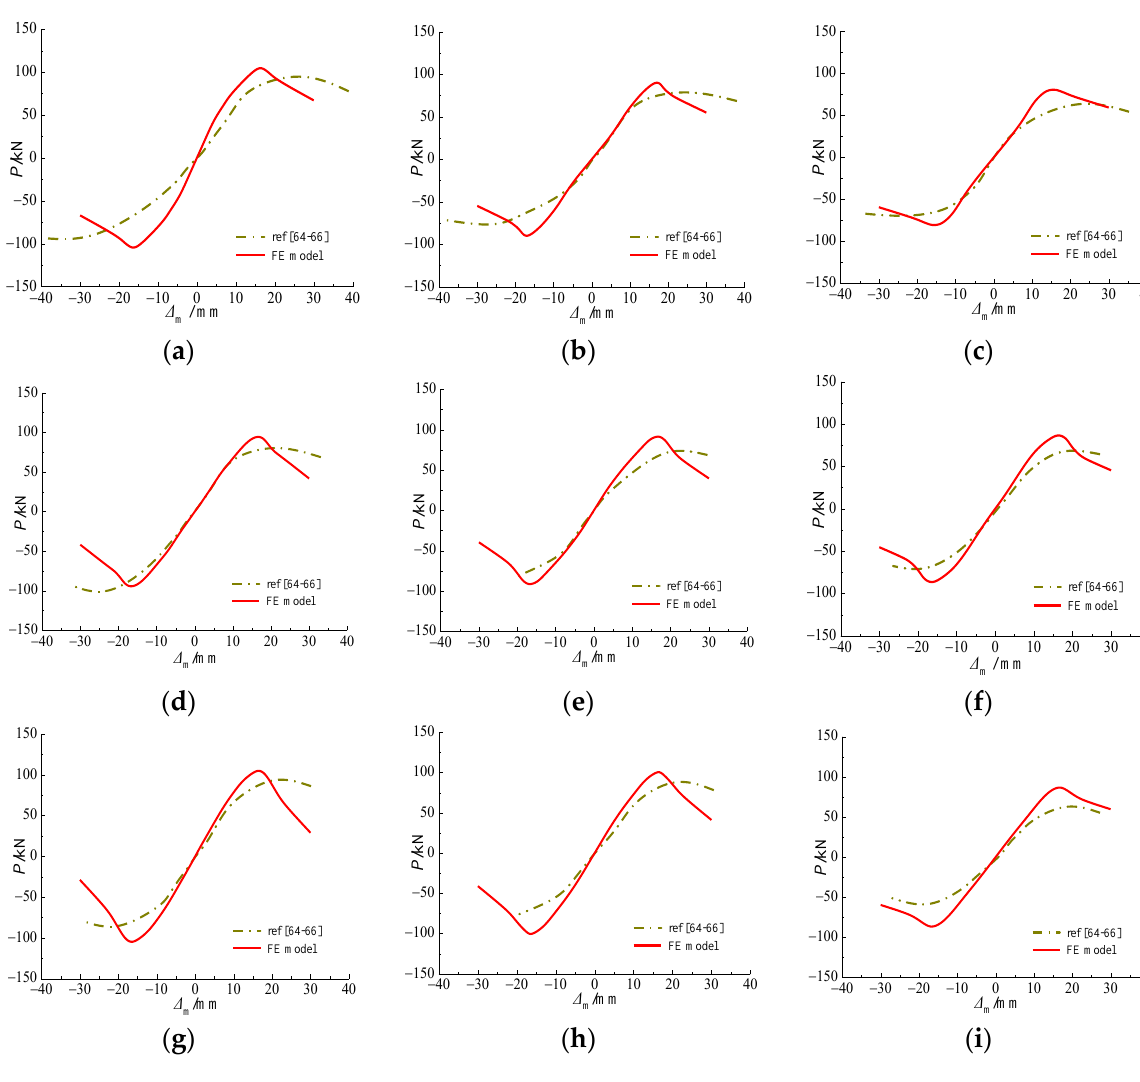
Figure 11. Comparison between FE model and test results of specimens after sulfate corrosion. ( a ) RC-0A; ( b ) RC-10A; ( c ) RC-20A; ( d ) RC-0B; ( e ) RC-10B; ( f ) RC-20B; ( g ) RC-0C; ( h ) RC-10C; ( i ) RC- 20C.